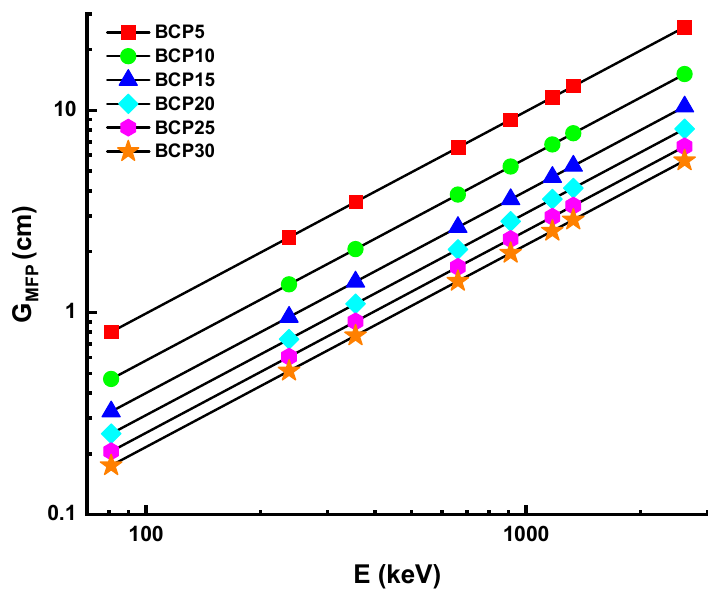
Figure 7. Variation of mean-free path (G MFP ) for prepared glasses.